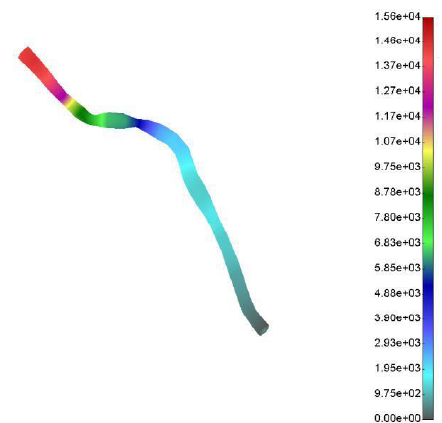
Figure 5. Pressure distribution of second patient [Pa] Values for FFR were obtained with three